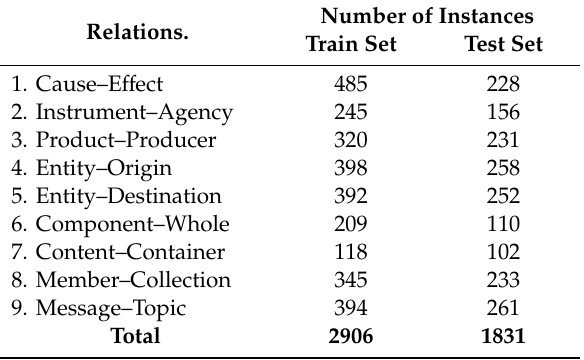
Table 6. List of predefined relations in the Semeval-2010 corpus and their number of occurrences.